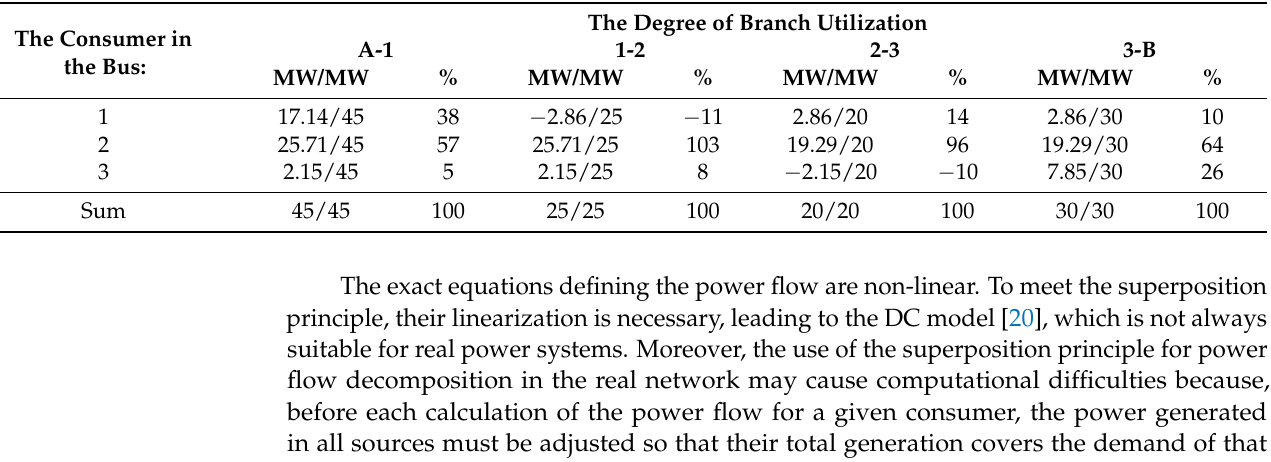
Table 5. The degrees of individual branch utilization by all consumers, resulting from the power flow decomposition by the superposition principle–the base case power